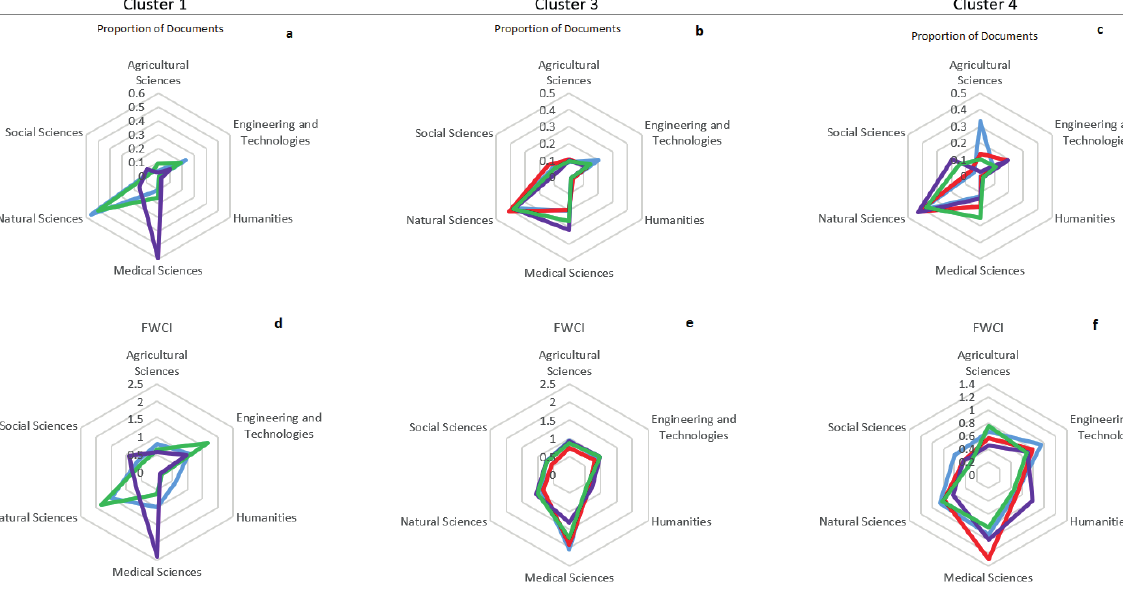
Figure 8. Proportion of Documents published in each OECD area of knowledge (a,b, and c) and impact (Field Weighted Citation Index - FWCI) of these publications (d, e and f) from randomly selected universities (different colours) in clusters 1, 3 and 4, respectively. (Cluster 1 has highest impact factor and Cluster 5